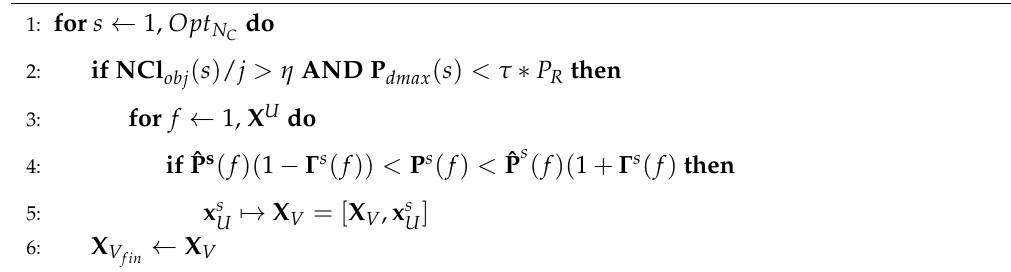
valid objects to X f